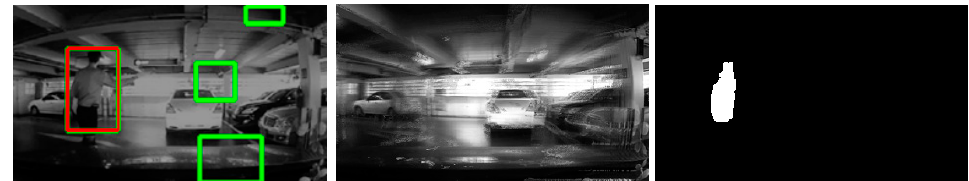
Figure 4. Derived frame difference ( right ) for false-positive filtering. The difference is derived between a frame ( left ) and its background ( middle ) with adequate threshold.